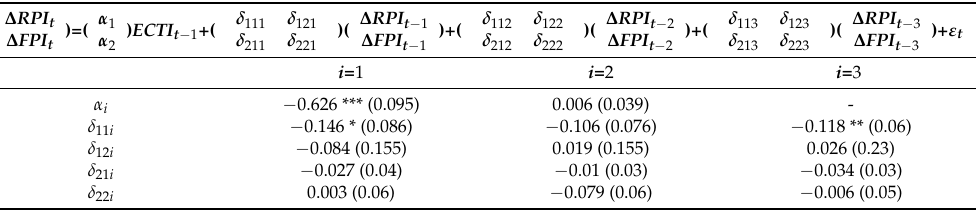
Table 8. Short-run estimates for generic Caciotta